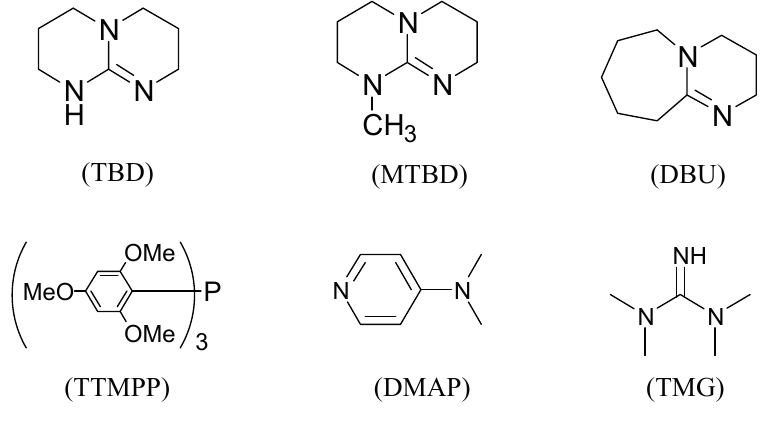
Figure 1. Various